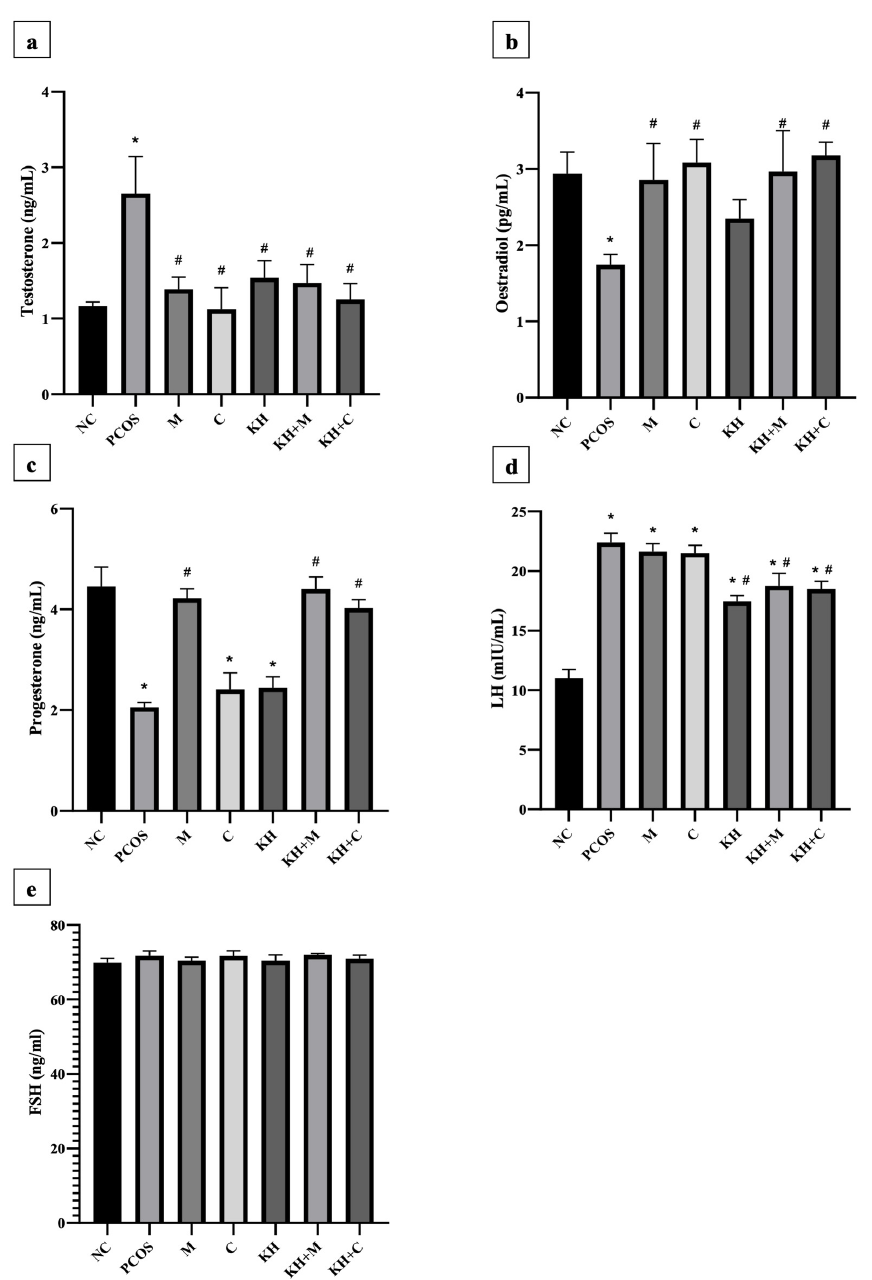
Figure 6. Effects of KH on serum ( a ) testosterone, ( b ) oestradiol, ( c ) progesterone, ( d ) LH, and ( e ) FSH levels. NC: normal control; PCOS: Untreated PCOS; M: PCOS + Metformin; C: PCOS + Clomiphene; KH: PCOS + Kelulut honey; KH + M: PCOS + Kelulut honey + Metformin; KH + C: PCOS + Kelulut honey + Clomiphene. * p < 0.05 significance against the normal control group, # p < 0.05 significance against the untreated PCOS group. n = 6 per treatment group.